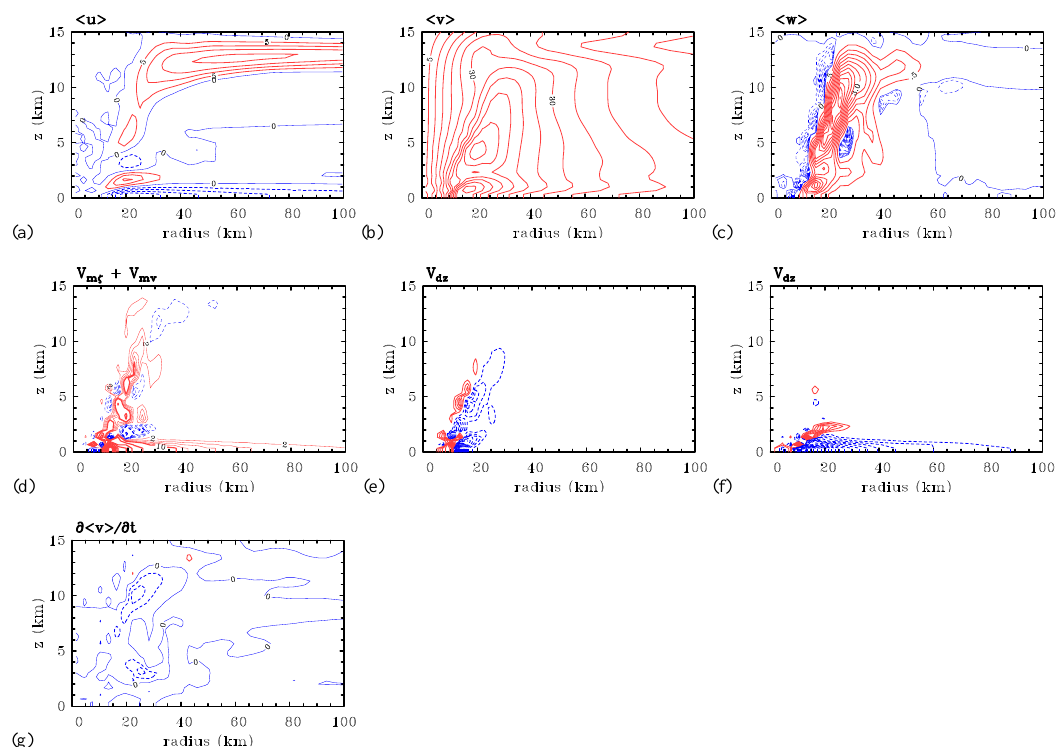
Fig. 13. Terms of the tangential wind tendency equation for the simulation AX3k, averaged during the mature stage (176 - 200 h). Red color denotes positive values; blue color denotes negative values. (a) Radial velocity h u i (Contour interval 5 m s − 1 ); (b) Tangential velocity h v i (Contour interval 5 m s − 1 ); (c) Vertical velocity h w i (Contour interval for positive 0.5 m s − 1 ; negative contours -0.05, -0.1, -0.15, -0.2 m s − 1 ); (d) Sum of mean vorticity influx and vertical advection V mζ + V mv (Contour interval: thin, 2 m s − 1 h − 1 ; thick, 10 m s − 1 h − 1 ); (e) Radial (subgrid-scale) diffusive tendency V dr (Contour interval 2 m s − 1 h − 1 ); (f) Vertical (subgrid-scale) diffusive tendency V dz (Contour interval 2 m s − 1 h − 1 ); (g) Mean tangential wind tendency ∂ h v i /∂t (Contour interval 0.2 m s − 1 h − 1 ) .